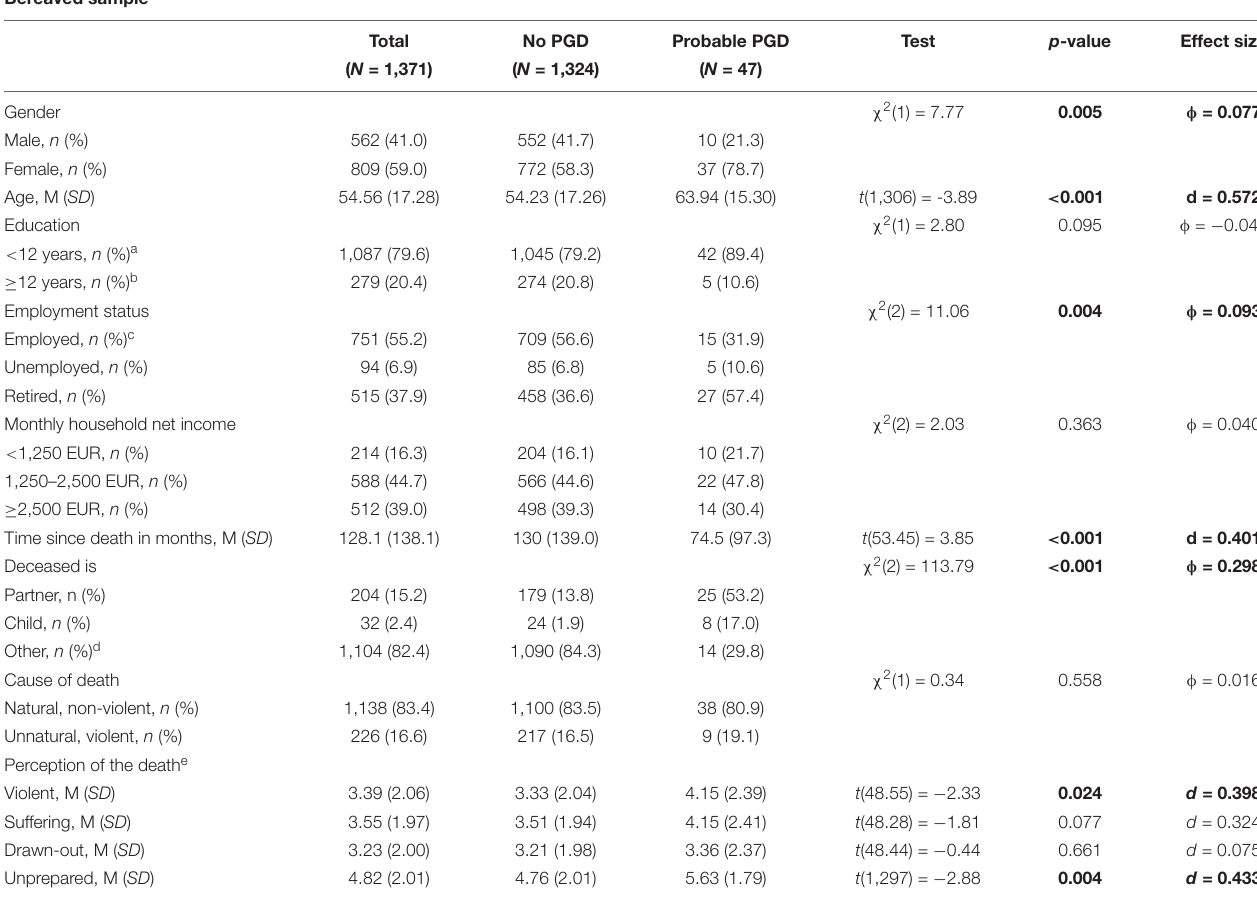
TABLE 1 | Participant characteristics and differences between people with and without probable